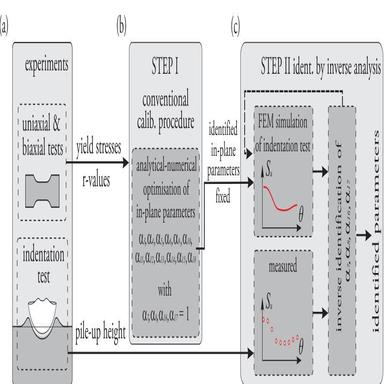
Presents the proposed two-stage procedure for identifying plastic anisotropy. First, uniaxial tensile test data and biaxial test data (a) are used as input for STEP I, which involves a conventional calibration procedure to determine the "in-plane" parameters (b). In STEP II (c), the pile-up height profile measured from the IIT is used as input for the identification process, with the in-plane parameters fixed. This step is based on FEM simulation of the IIT response.